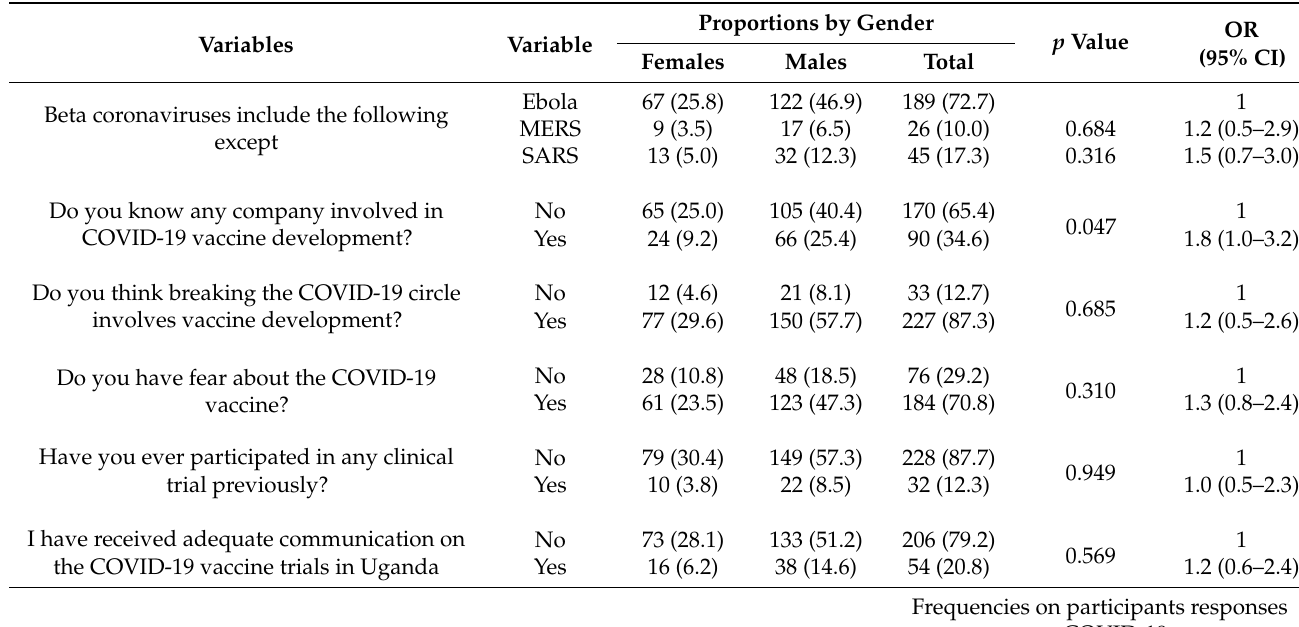
Table 3. Descriptive narrative on knowledge, trust and confidence among study participants.